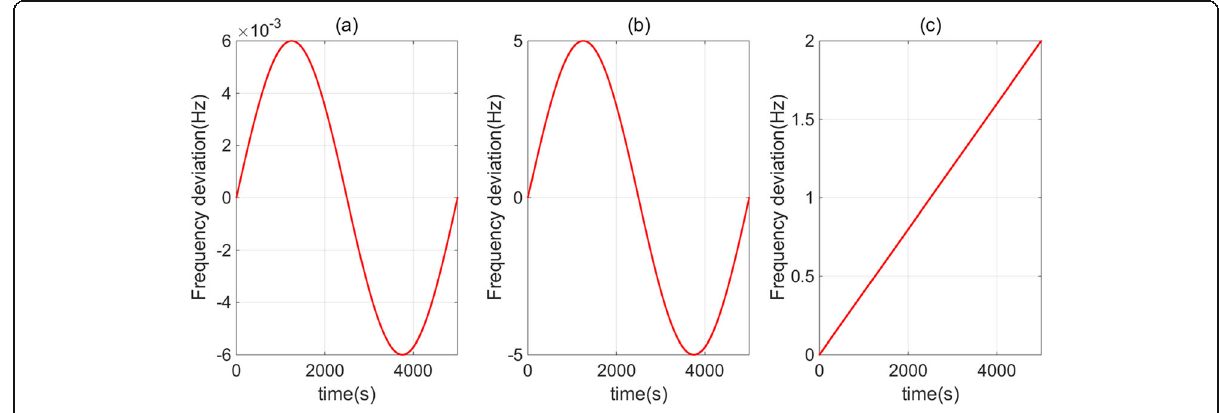
Fig. 7 The curve set in the simulation